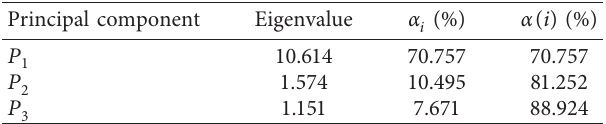
Table 2: Original eigenmatrix principal component analysis